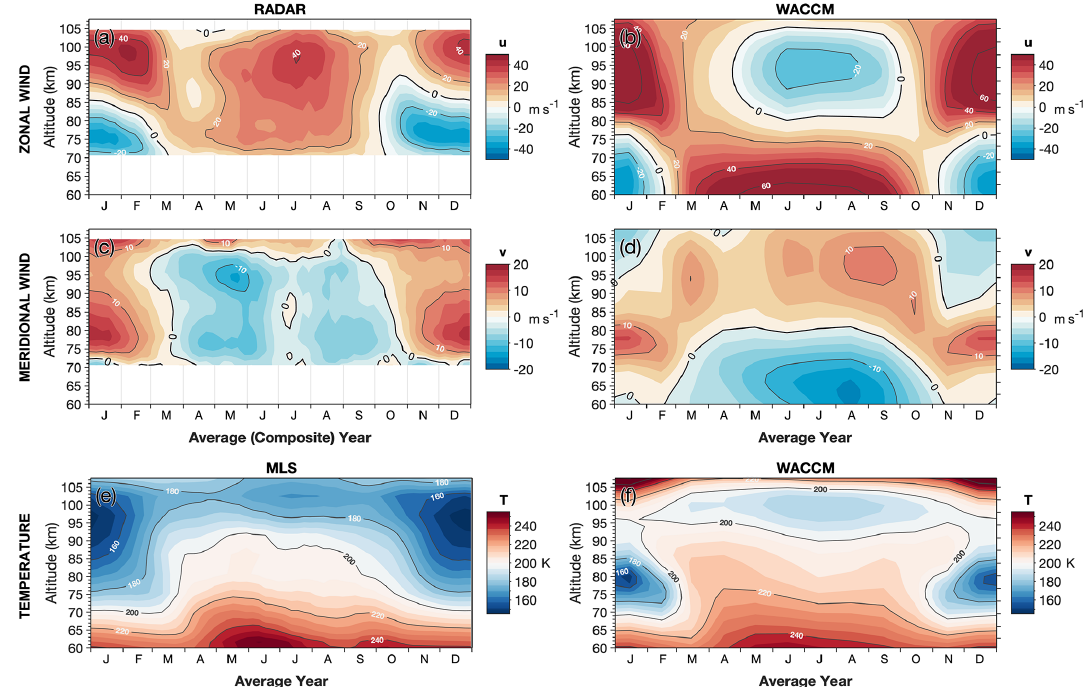
Figure 8. Comparison of an average year of meteor radar-derived zonal (a, b) and meridional (c, d) winds and satellite-derived temperature measurements from MLS (e, f) in the mesosphere and lower thermosphere with climatological winds and temperatures from WACCM simulations over South